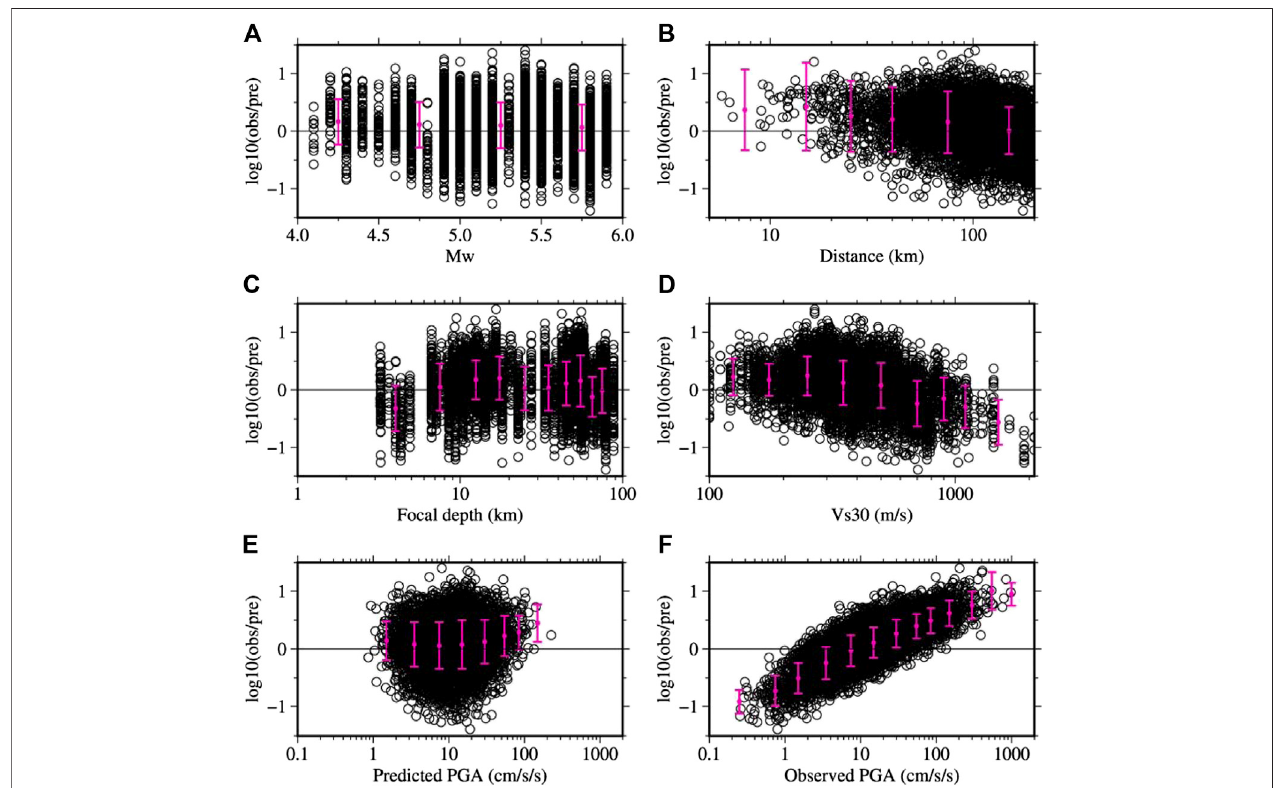
FIGURE5| PlotsofresidualsforPGAdataplottedin Figure3A forhypocentraldistancessmallerthan200 km.The (A – F) showthedistributionofresidualsagainst the Mw, hypocentral distance, focal depth, Vs30, predicted PGA, and observed PGA, respectively. The vertical bars denote the mean values with plus-minus one standard deviation of the binned